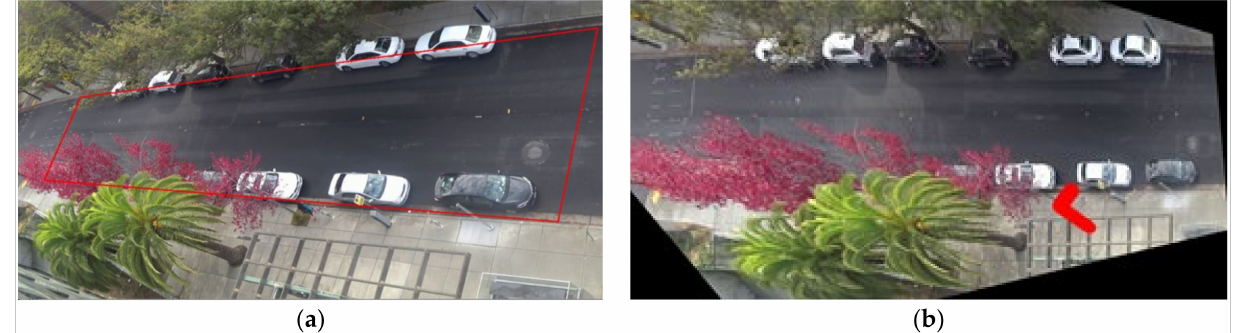
Figure 9. Comparison before and after image preprocessing. ( a ) is the picture before processing, ( b ) is the result of highlighting the target pedestrian and perspective transformation.